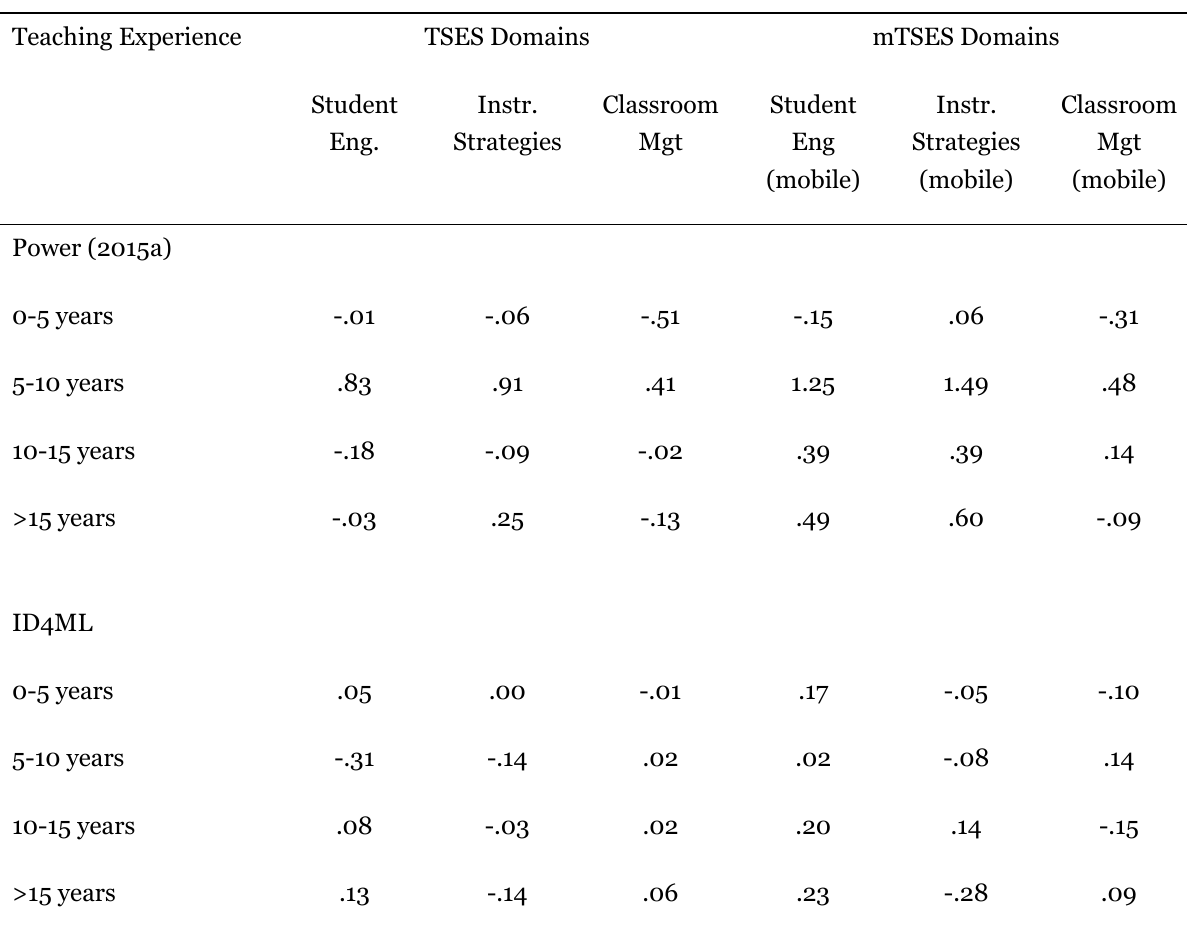
Changes in TSES and mTSES Scores by Years of Teaching Experience Teaching